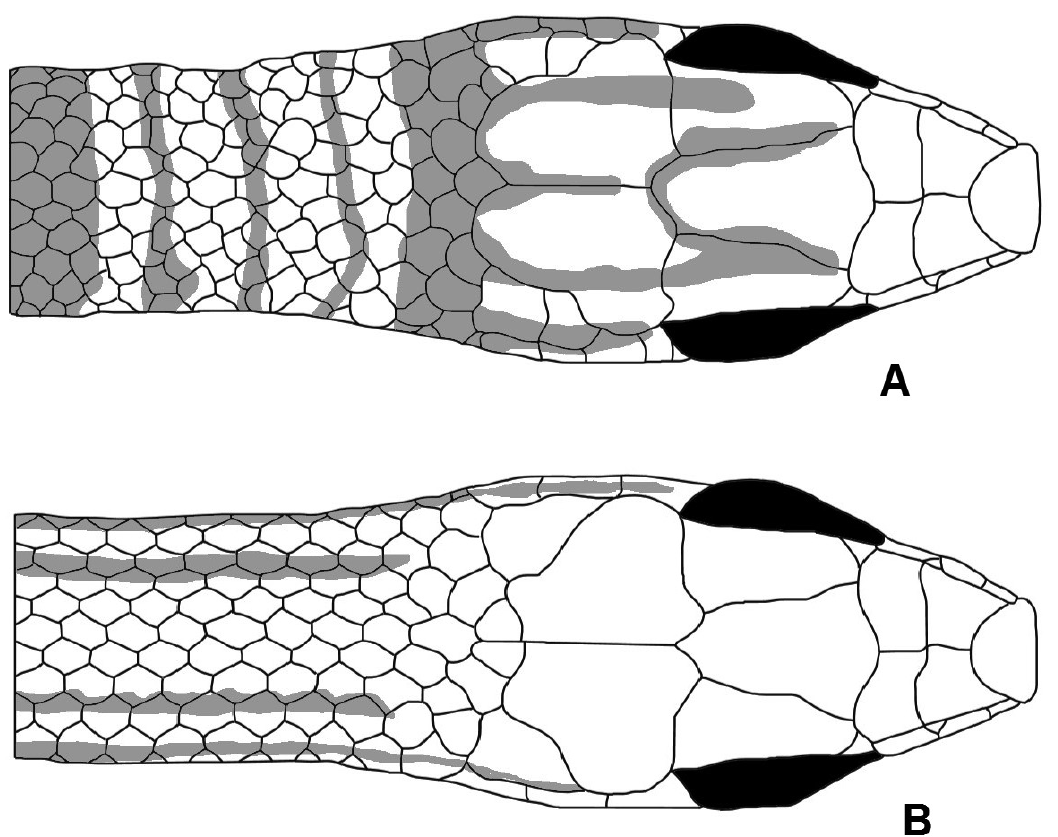
Fig. 13. A . Longitudinal lines interrupted in the first third of the body. B . Longitudinal lines extending along